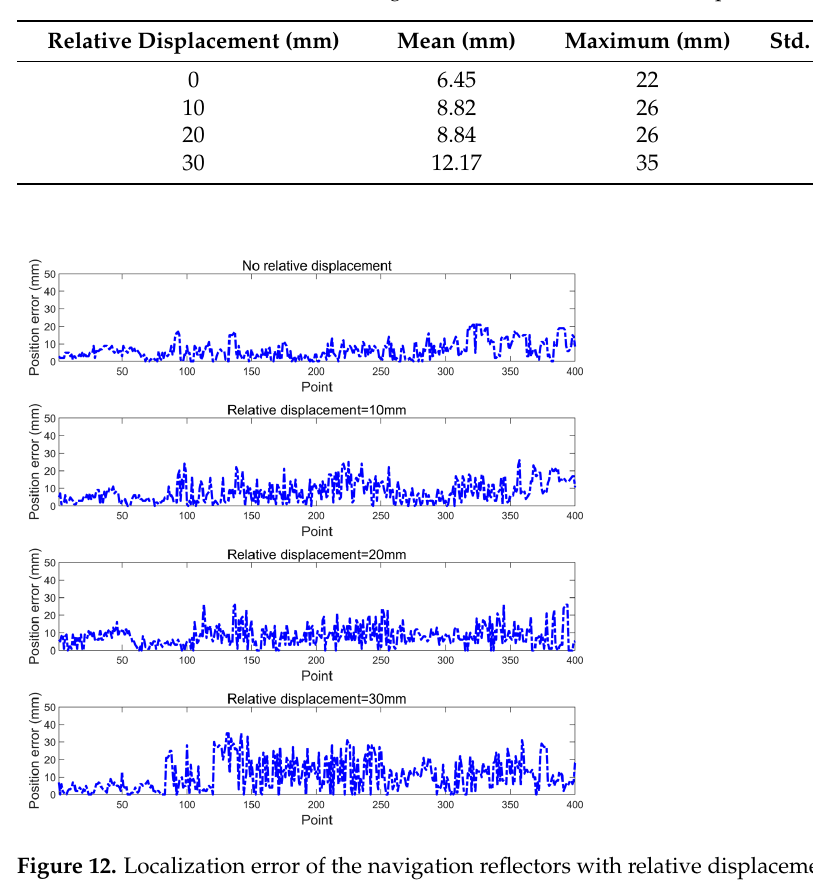
Figure 11. Robot motion trajectory and navigation map: ( a ) motion compensation mode turned on; ( b ) motion compensation mode turned off. Table 7. Localization error of the navigation reflectors with relative displacement.